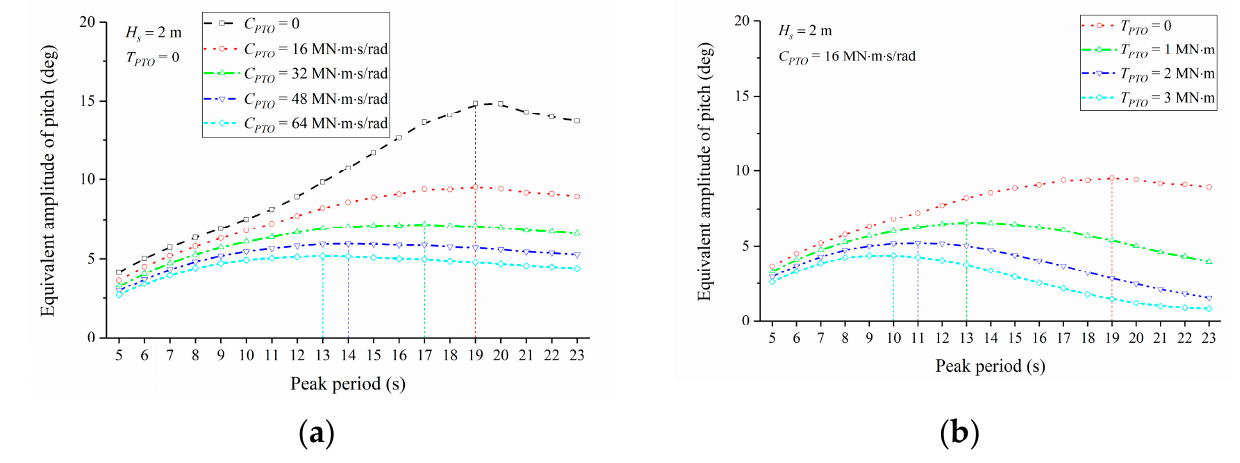
= 2 m in 𝑠 = 0 ; ( b ) various values of and 𝑇 (cid:3017)(cid:3021)(cid:3016) (cid:3017)(cid:3021)(cid:3016)